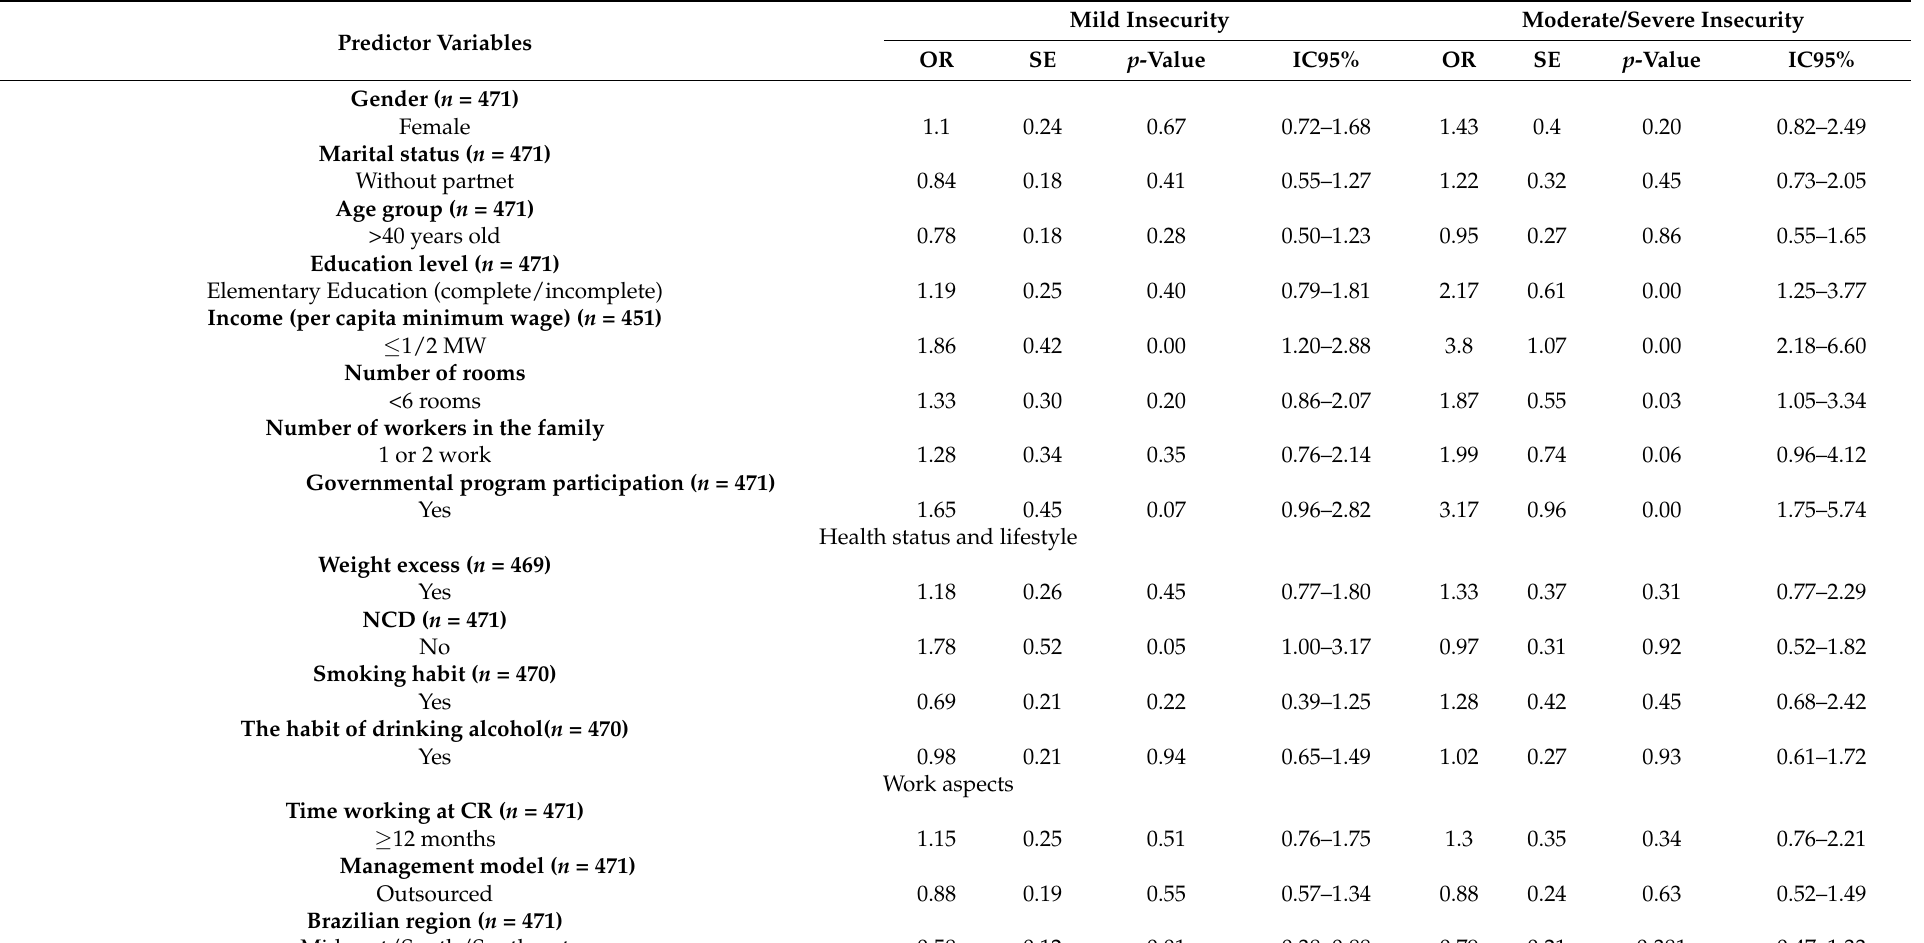
Table 2. Bivariate multinomial logit model with odds ratio (OR) estimation between household food security situation (reference group: food security) and demographic, socioeconomic, health, lifestyle predictors, and those related to work in a Community Restaurant in all the Brazilian